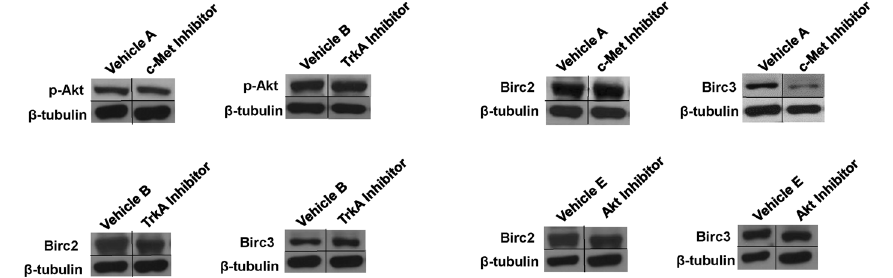
Figure 7. HGF/c-MET and NGF/TrkA signaling pathways influence esophageal epithelial regeneration in an Akt independent manner and in some cases modulate the expression of the anti-apoptotic protein, Birc3. Immunoblot analyses of p-Akt, Birc2, Birc3, and β-tubulin protein expression levels from neotissues treated with vehicle or inhibitors for 7 days of scaffold implantation. Vehicle and inhibitor-treated comparisons were made on the same immunoblots and with equal amounts of protein loaded per lane (N = 3–4 animals per group). Targeted bands were cropped from original full length immunoblots displayed in Supplementary Fig. S2.